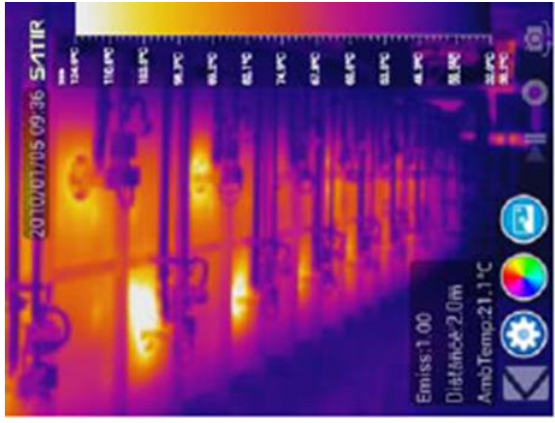
Figure 7. Firing zone of the continuous kiln of unit two before any improvement (source: Energy Audit Report 2018.